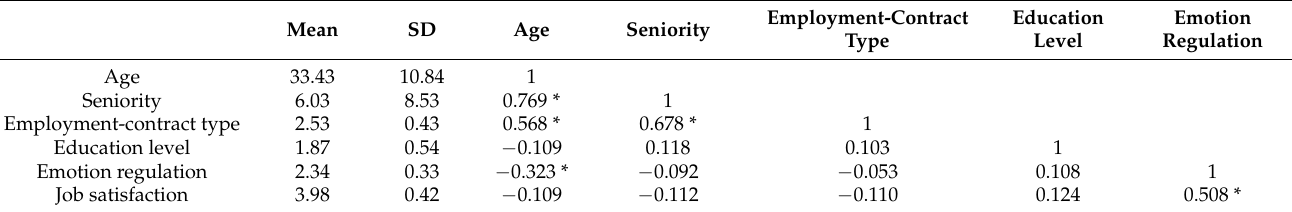
Table 2. Means, standard deviations, and correlations between variables.